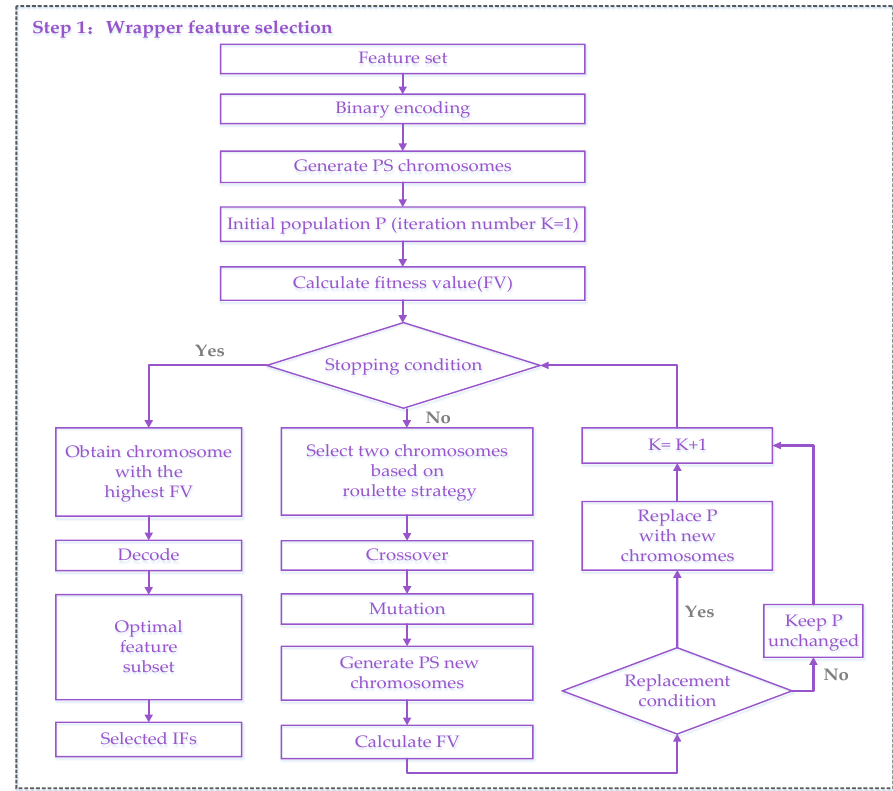
Figure 2. The detailed framework of step 1.